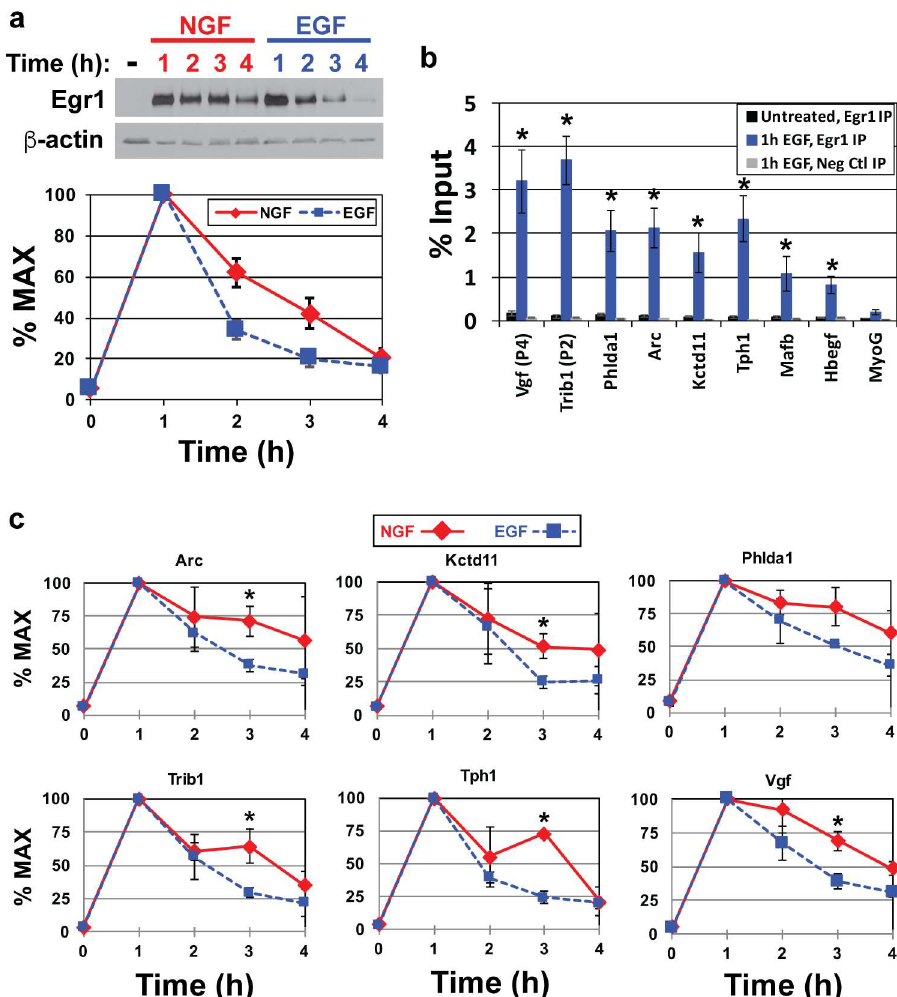
Fig 4. Sustained Egr1 expression and binding upstream of target genes in response to NGF versus EGF. (a) PC12 cell cultures were treated with 50 ng/ml NGF or 25 ng/ml EGF for 0–4h. Total cell lysates were harvestedandsubjectedto SDS-PAGE andWestern blot for Egr1. Egr1 levels were quantified by densitometry andconvertedto % maximumlevels for ten independent experiments and plotted(average ± S.E.). (b) PC12 cultureswere treated with or without25 ng/mlEGF for 1 h and subjectedto ChIP assay usingantibodiesagainst Egr1 or an IgG control.Real-timePCR was then conducted on the immunoprecipitatedDNA usingprimers within250 bp of predictedEgr bindingsites (see Fig 1 andS2 Tablefor primerlocationsandsequences). Primers to amplifya regionapproximately 100bp upstreamof the Myog genewere used as a negativecontrol for Egr1 binding.Data are plottedas % input andare averagesfrom three to six independent experiments ± S. E. * , One-tailedStudent’s t tests were conductedcomparing the % input valuefor Myog after Egr1 IP to the % inputvaluesfor each predictedEgr target after Egr1 IP, whichyielded p values (cid:20) 0.05. (c) PC12 cell cultures were treated with 50 ng/ml NGF or 25 ng/mlEGF for 0–4h and subjectedto ChIP with anti-Egr1antibody. ImmunoprecipitatedDNA was then subjectedto real-time PCR with primersto detect Egr1 bindingto a subset of its target genes, which was quantifiedas % input. Percent inputvalueswere then convertedinto % maximum values,whichwere plotted. * , One-tailedStudent’s t tests were conductedcomparing the % inputvaluesat each time pointafter NGF versus EGF treatment, whichyielded p values (cid:20) 0.05 at the 3-hourtime pointfor Arc , Kctd11 , Trib1 , Tph1 ,and Vgf